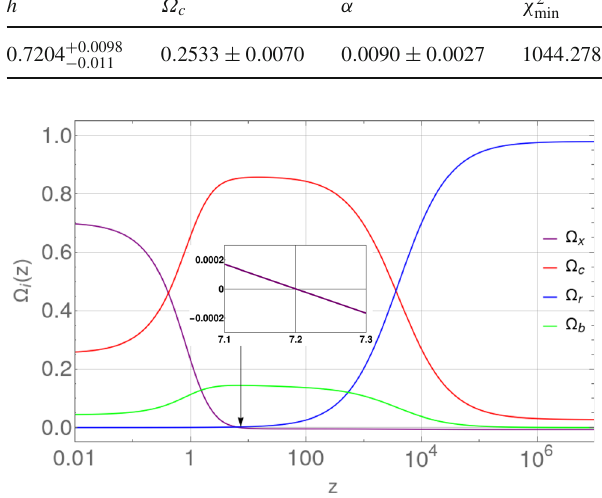
Fig. 10 Evolution of the density parameters for the model Γ 1 T con- sidering the best fit parameters in Table